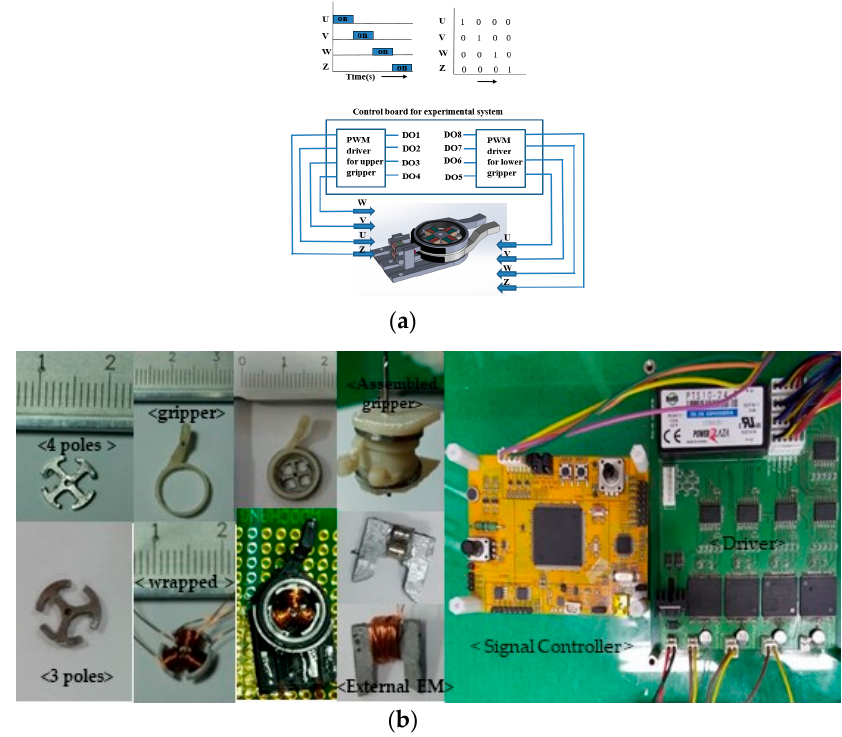
Figure7. Drivingmethodandexperimentaldevice: ( a )Experimentmethodofthetotalsystem;( b )Fabricated parts, EM of the proposed gripper, and Experimental device for driving the proposed